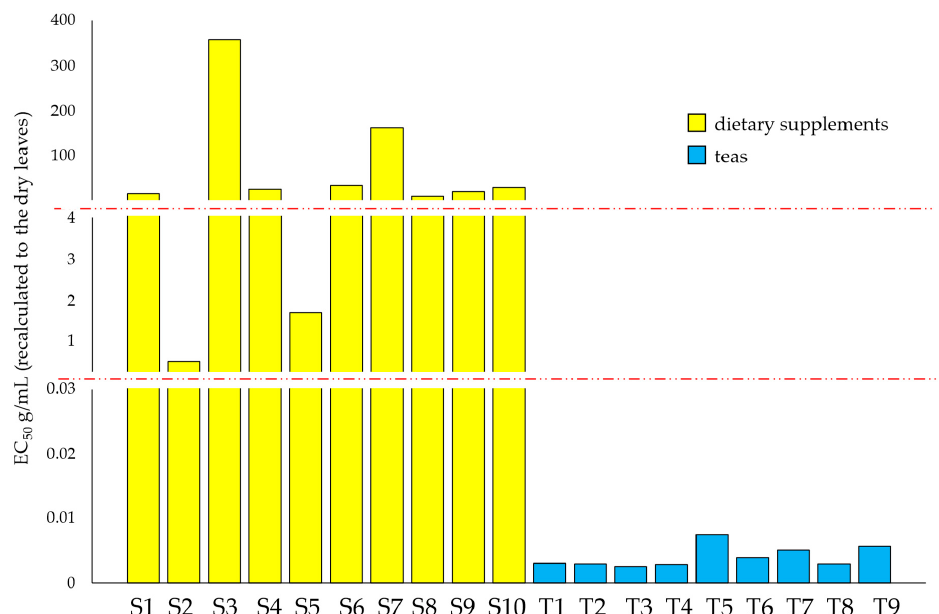
Figure 5. Results of DPPH • assays (as EC 50 ) of white mulberry teas and dietary supplements (recalculated to the dry leaves). The red dotted lines indicate the gaps on the scale, for EC50 values between 0.03-0.1 g/mL and between 4-10 g/mL).